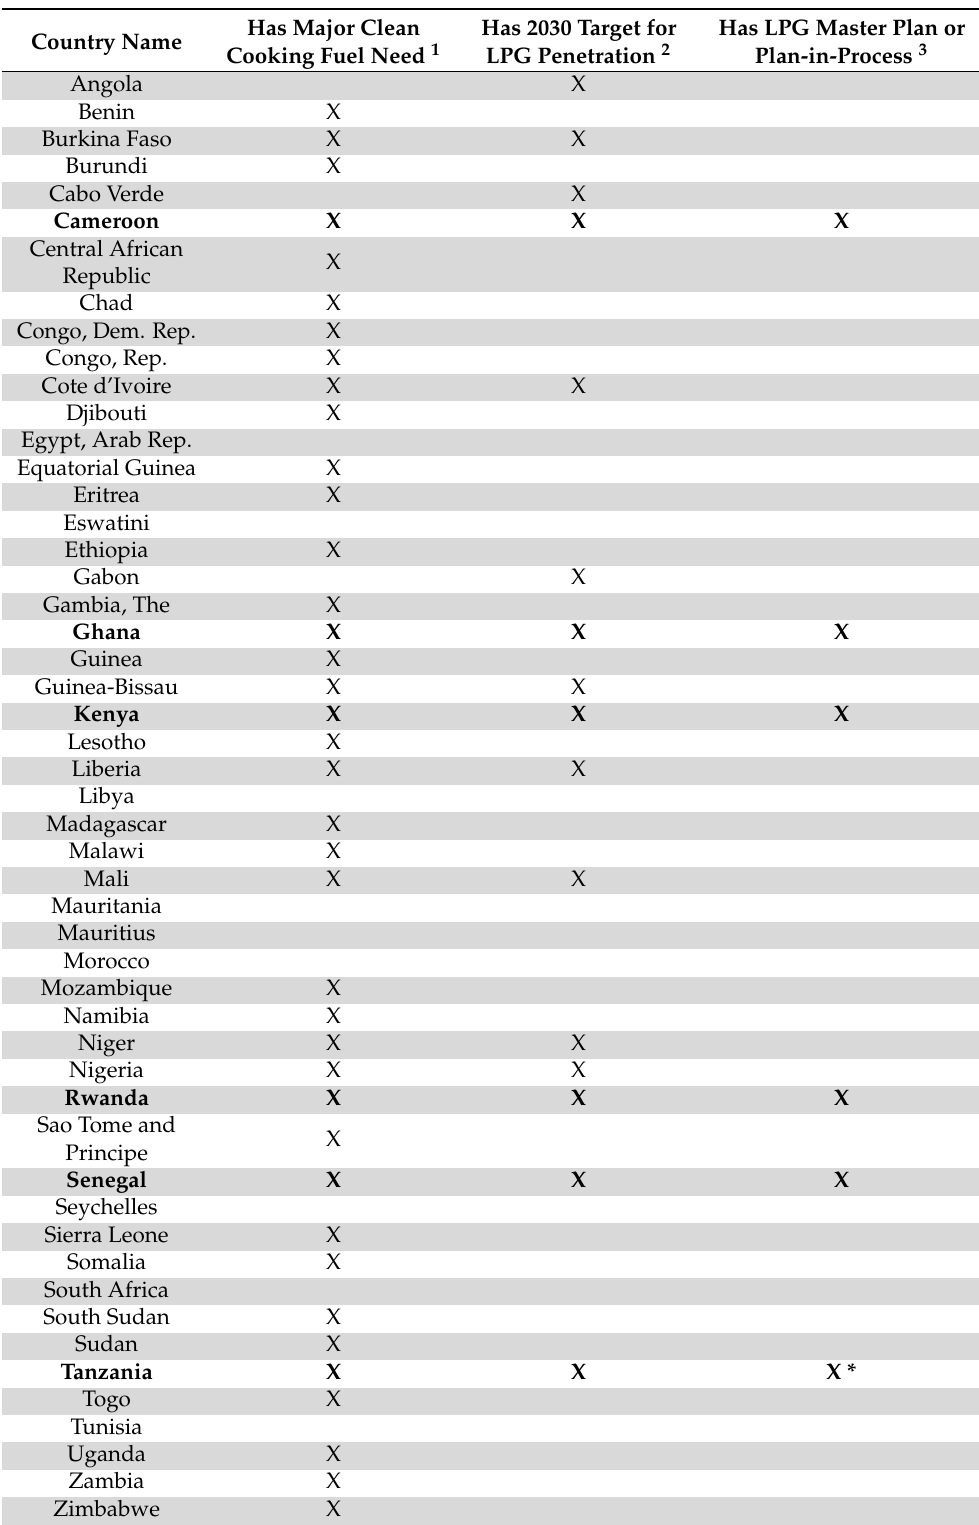
Table 1. Screening and selection of SSA focus